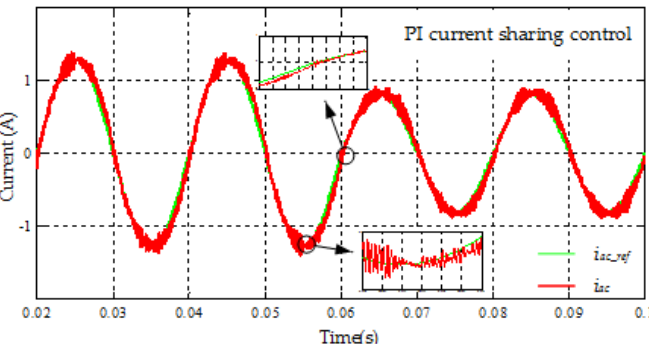
Figure 7. Simulation results of case 1: output grid current response of the interleaved flyback micro-inverter controlled by a PI controller.